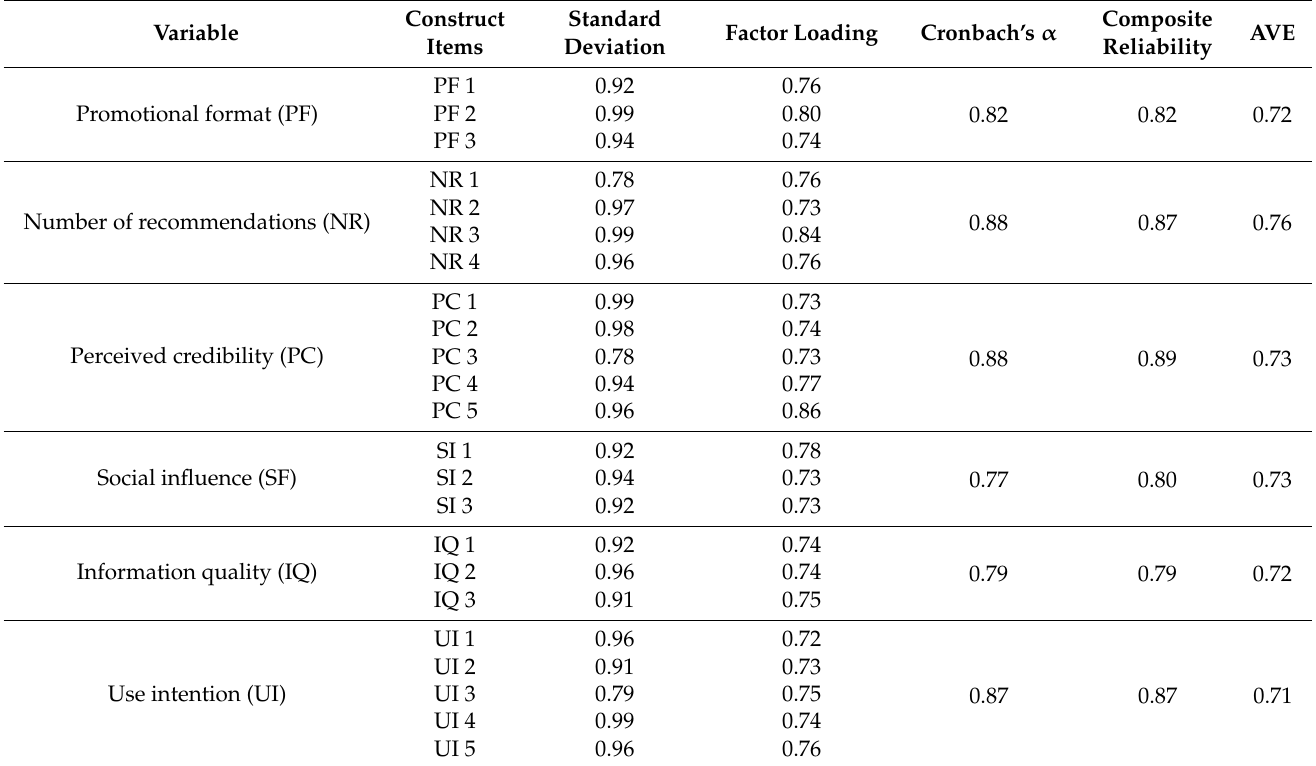
Table 3. Summary of measurement scales.